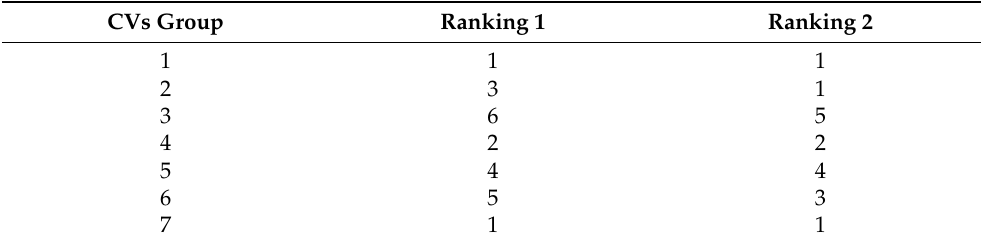
Table 9. Rotary kiln APC system: priority rankings for constraints